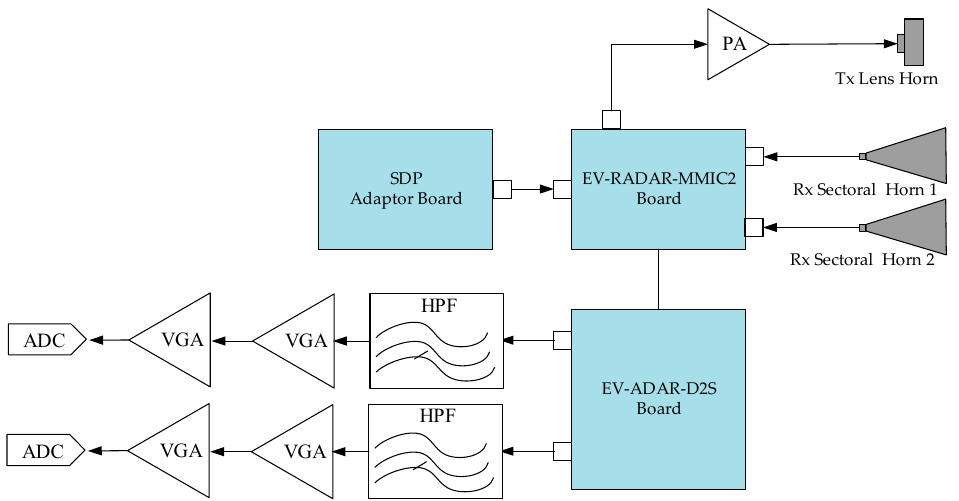
Figure 8. Block diagram of the implemented 24-GHz transceiver and Intermediate Frequency (IF) module. Sensors 2018 , 18 , x FOR PEER REVIEW